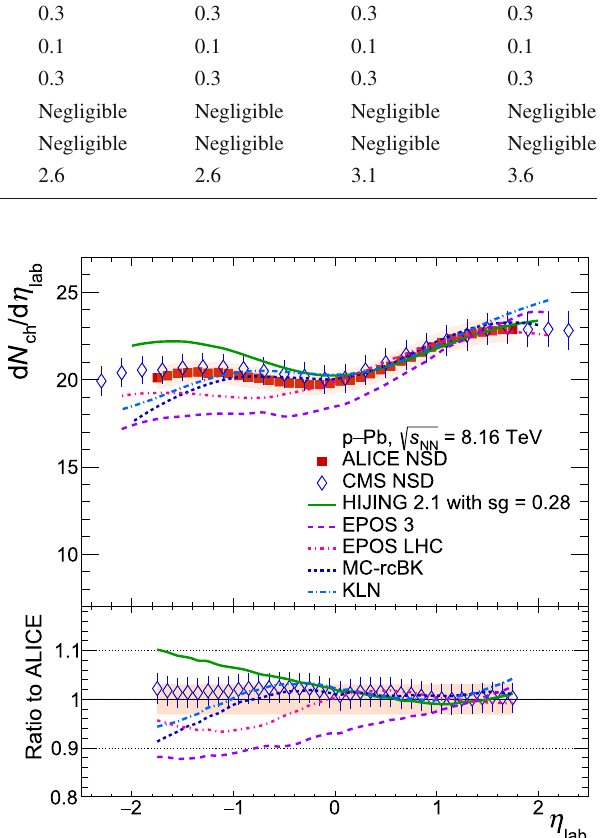
Fig. 3 Red squares show the measured pseudorapidity density of charged particles in p–Pb NSD collisions at ALICE, with total systematic uncertainties shown as bands, compared with CMS results [37] and theoretical predictions shifted to the labo- ratory system [12,14,17,18,20]. The bottom panel shows the ratio to ALICE data